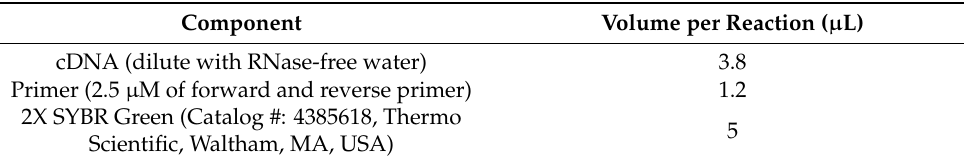
Table 4. Components of QPCR reaction. Component cDNA (dilute with RNase-free water)